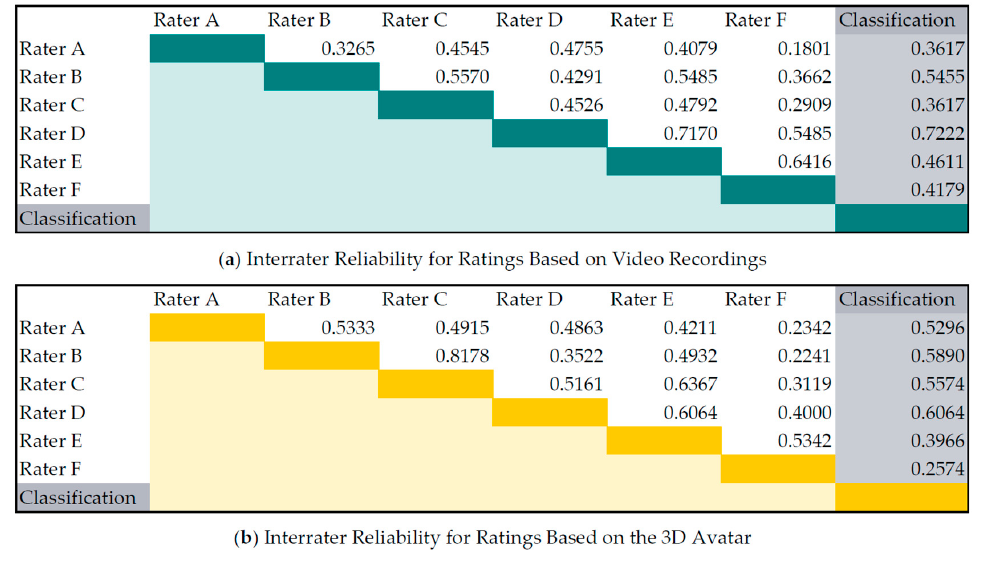
Figure 7. Interrater reliability for ratings based on ( a ) video recordings and ( b ) animated 3D avatar. Reliability is computed with weighted kappa coefficient.